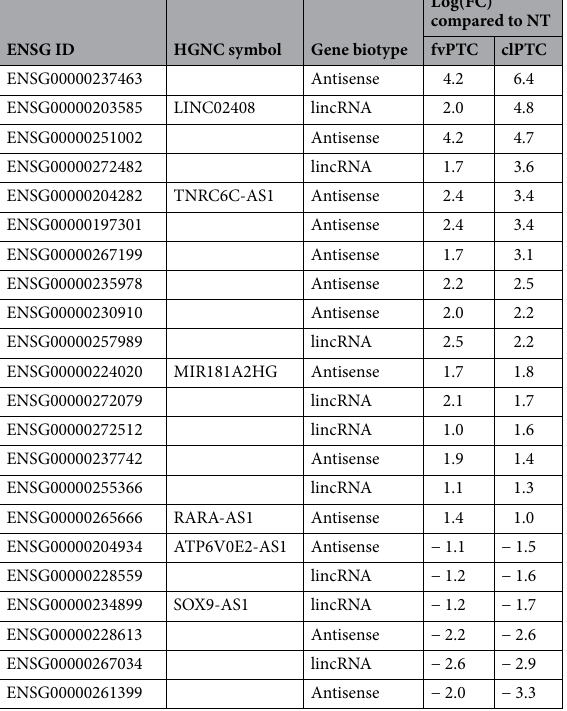
Table 4. LncRNAs common for papillary carcinomas. These lncRNAs are validated and differentially expressed compared to FA and FTC.